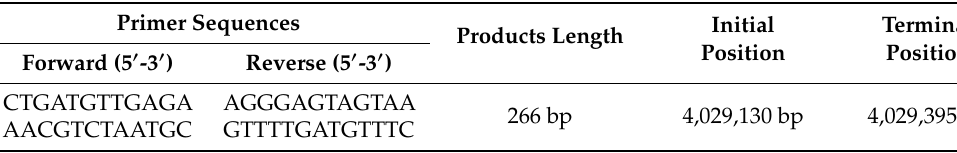
Table 3. Sequences of the primers used to amplify the fragment flanking SNP-5.